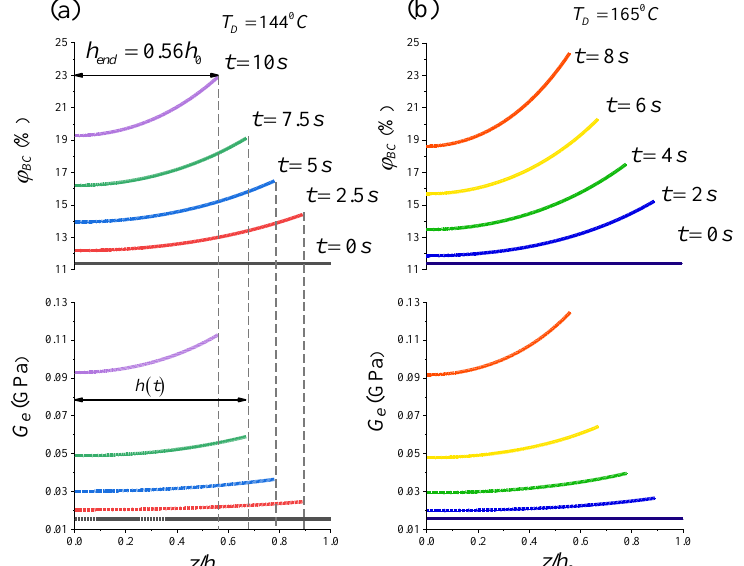
Figure 3. Concentration of ( a ) conductive additives (BC) and ( b ) effective shear modulus of NMC/PVDF/CB slurry across electrode thickness at different drying times.